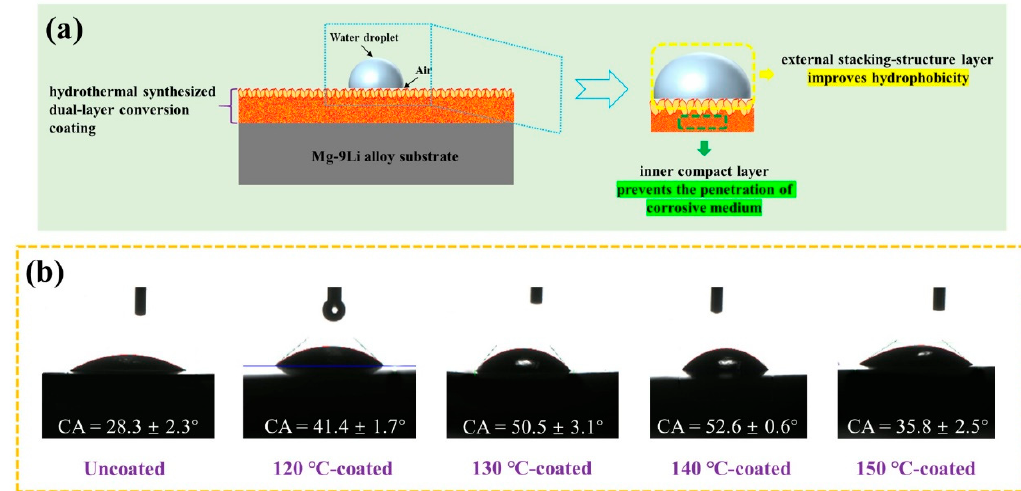
Figure 11. ( a ) Schematic diagram of hydrothermal conversion coating sample contact with water droplet. ( b ) The contact angle of the uncoated and coated samples.